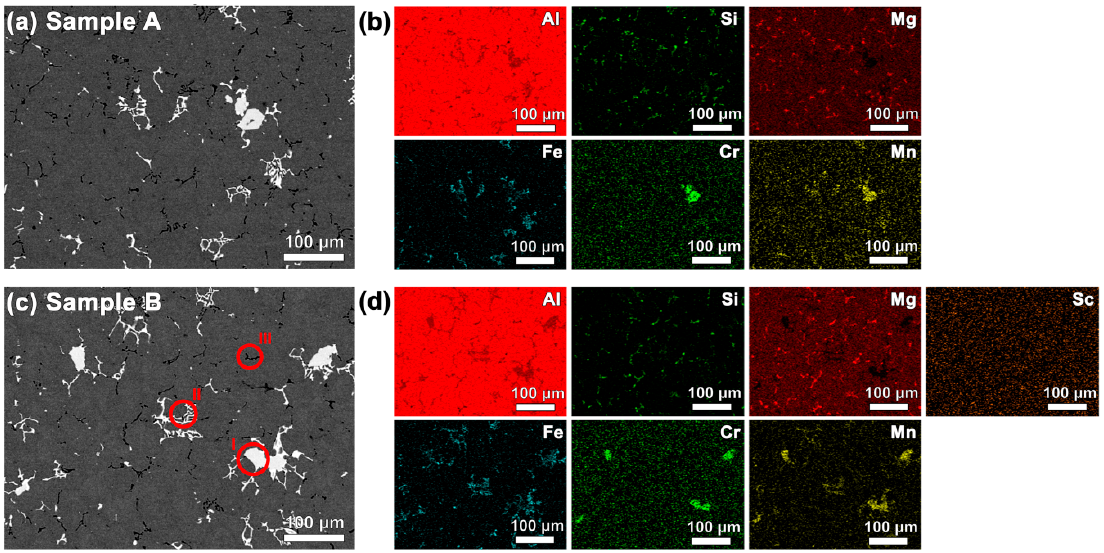
Figure 4. Typical BSE images of non-hot-rolled ( a ) sample A (Sc-free Al5083), ( c ) sample B (Sc-microalloyed Al5083) and ( b,d ) the corresponding elemental mapping results from SEM.